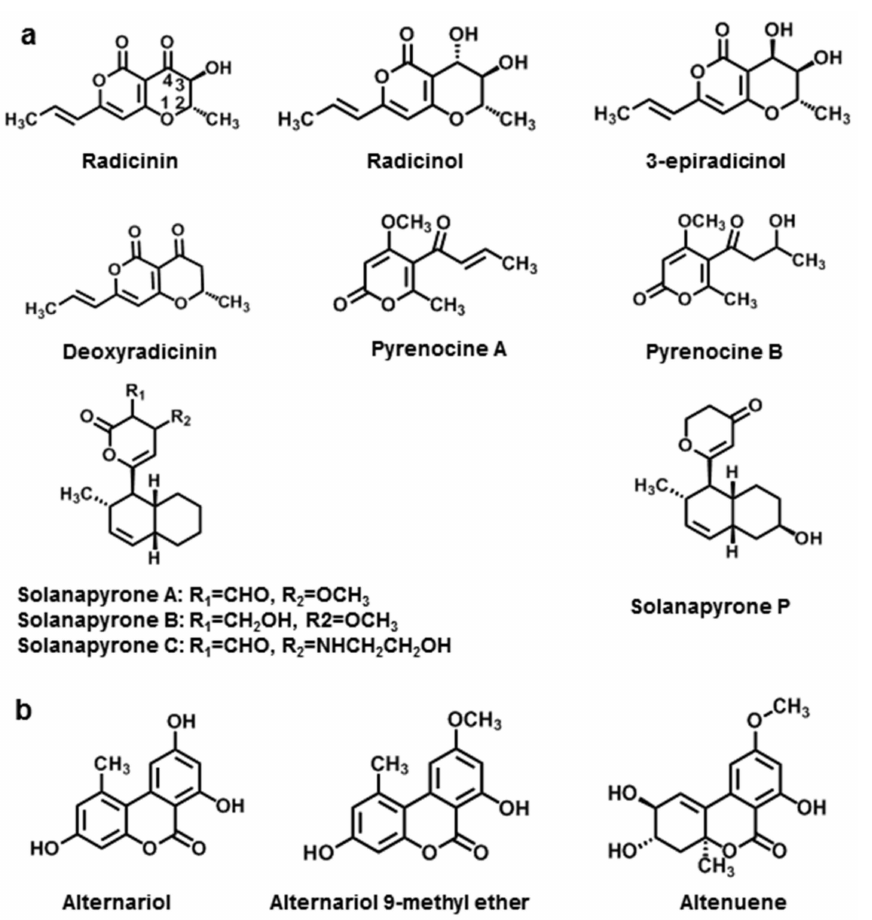
Figure 6. Chemical structures of Alternaria NHSTs belonging to simple pyranones ( a ) and dibenzopy- ranones ( b )